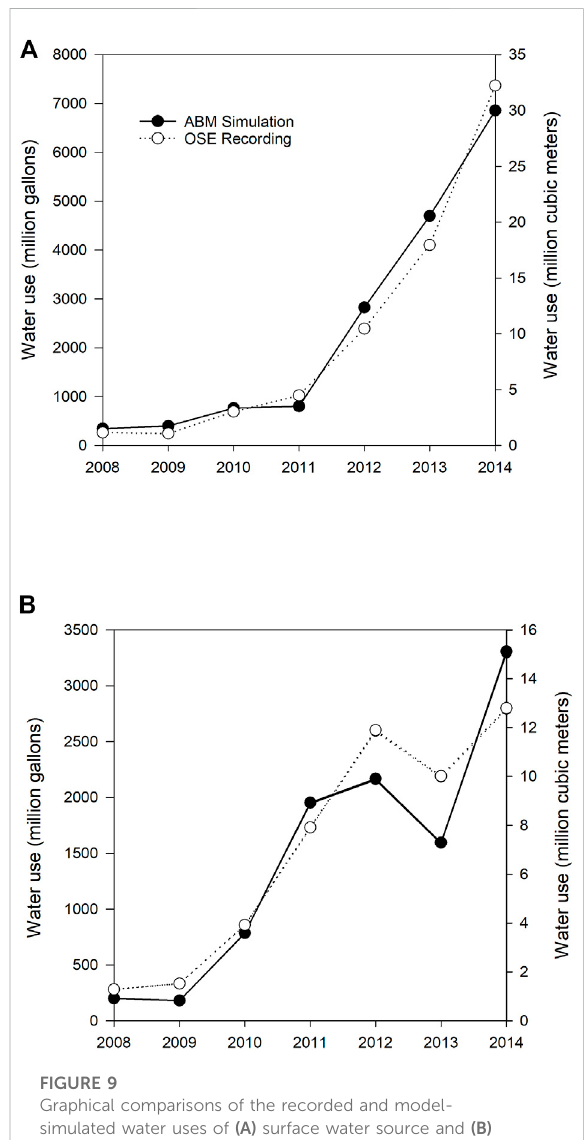
FIGURE 9 Graphical comparisons of the recorded and model- simulated water uses of (A) surface water source and (B) groundwater